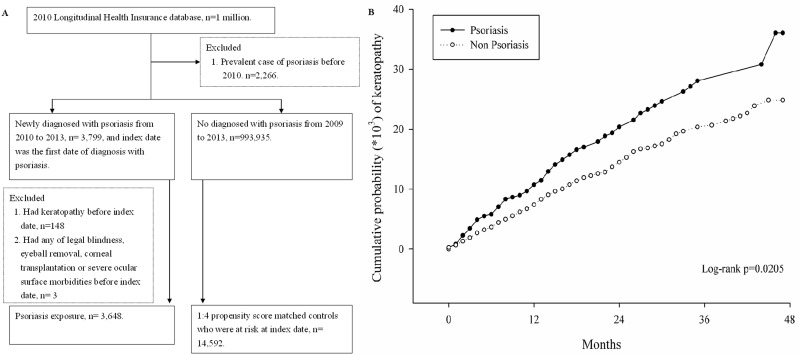
The flowchart of the enrollment of patients with and without psoriasis in the cohort study.